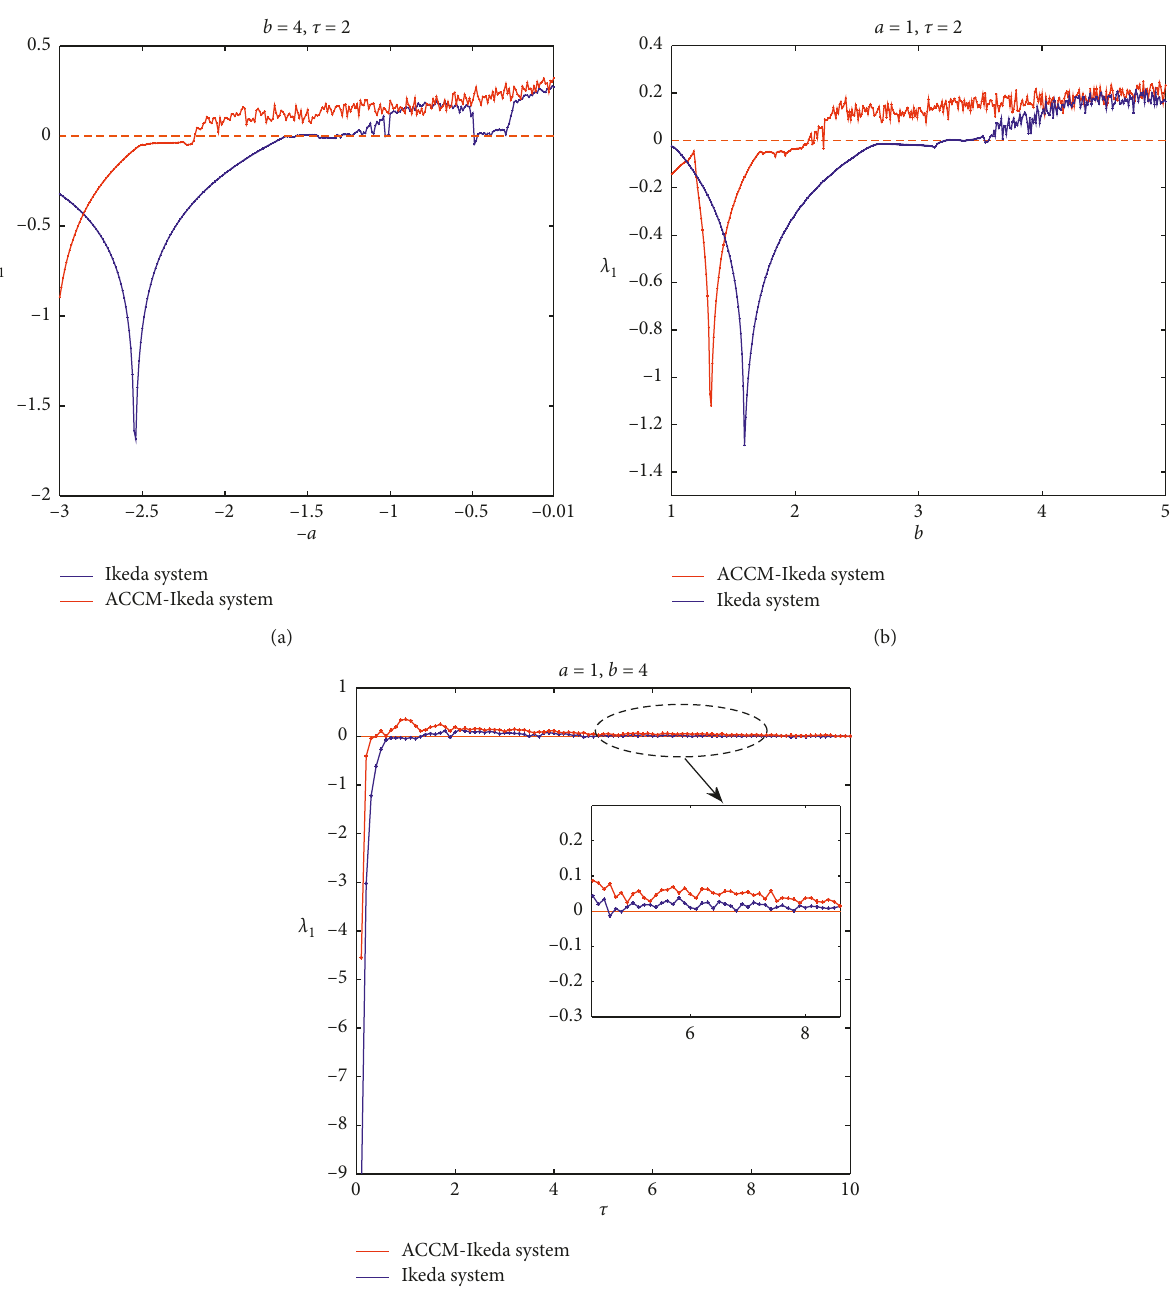
) comparison 1 ) comparison for bifurcation parameter τ 1